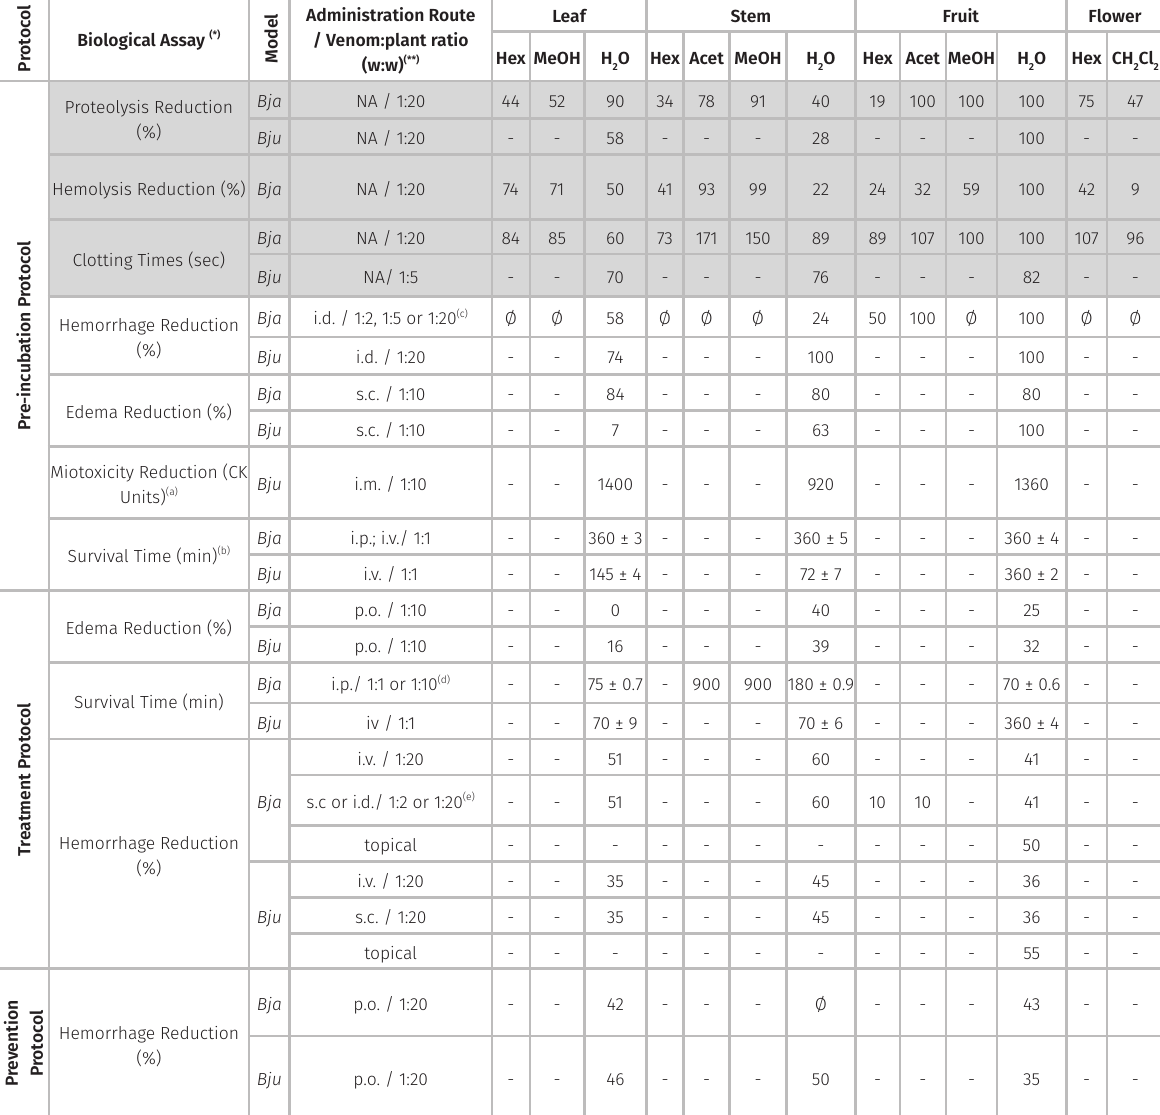
Data extracted from graphics and tables from de Oliveira et al. (2014) and da Silva et al. (2019b); Grayish background highlights the in vitro trials; Ø (inactive). *Referred values for control as (a) ca. 1500 CK units and (b) survival times of 120 minutes for organic extracts (de Oliveira et al. 2014) or 60 minutes (da Silva et al.